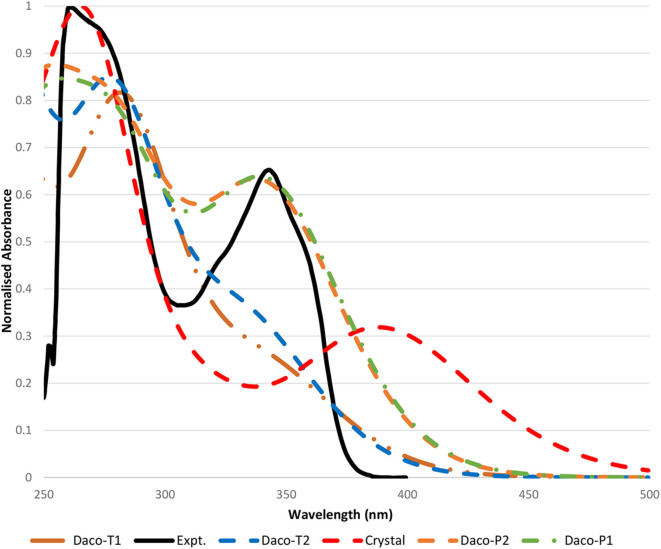
Comparison of the measured UV-Vis absorption spectra of Dacomitinib in the DMSO spectrum (solid black line) with that calculated (colored) in the same solvent. All spectra including both the calculated and the measured are normalized to their own individual maximum absorbances. Please note that the wavelength cutoff due to solvent is 250 nm, and the maximum absorbances of some Dacomitinib conformers lie in the region smaller than 250 nm.